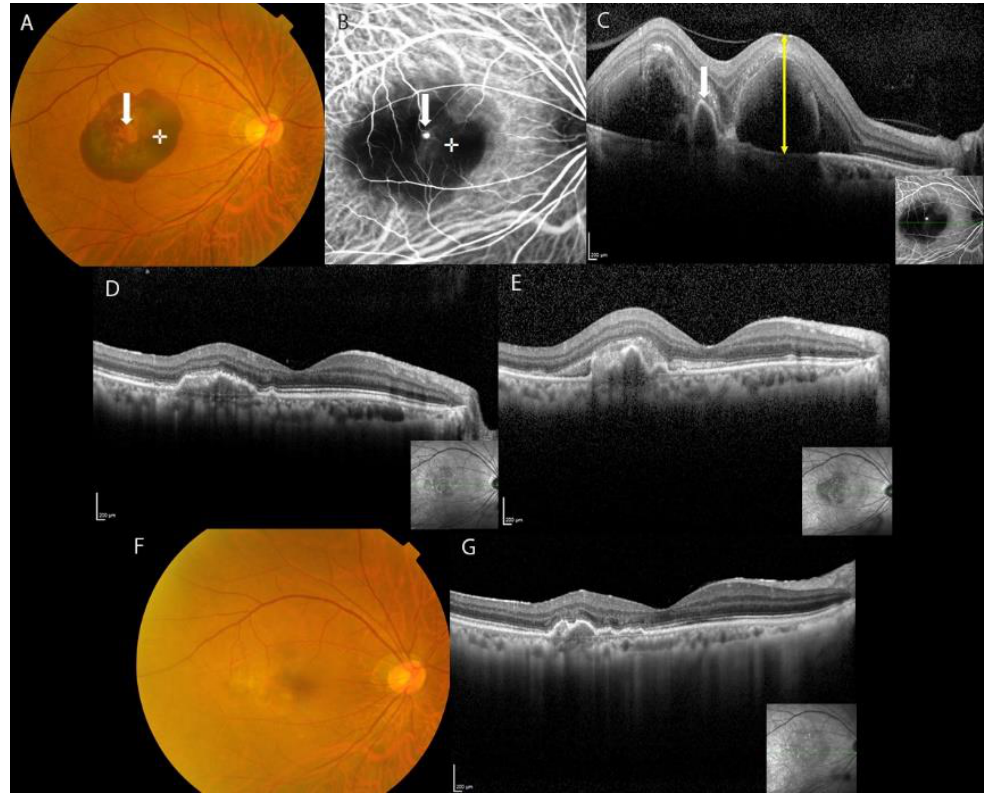
Figure 1. Image findings during the clinical course of a 65-year-old man with submacular hemorrhage secondary to polypoidal choroidal vasculopathy treated with intravitreal tissue plasminogen activator, ranibizumab and gas injections. Duration from onset to treatment was 4 days. ( A ) Before treatment, color fundus photograph shows submacular hemorrhage measuring 4 disc diameters involving the fovea. Reddish-orange polypoidal lesions (arrow) and the fovea (cross) are shown. ( B ) Pretreatment indocyanine green angiography shows a polypoidal lesion (arrow) and the fovea (cross). ( C ) Before treatment (ETDRS score 62 letters), optical coherence tomographic (OCT) image shows a polypoidal lesion with sharp-peaked pigment epithelial detachment (PED) (arrow). The central retinal thickness (CRT) is 642 µ m (yellow up-down arrow), and there is no PED in the fovea (CPEDT was 0). ( D ) At 3 months after treatment (ETDRS score 73 letters), OCT image shows CRT of 165 µ m and CPEDT of 0 µ m. ( E ) At 4 months after treatment, OCT shows a subretinal hemorrhage recurring at the macula. An intravitreal injection of aflibercept was performed. ( F ) At 12 months after treatment, fundus photograph shows the disappearance of submacular hemorrhage. There was only one recurrence